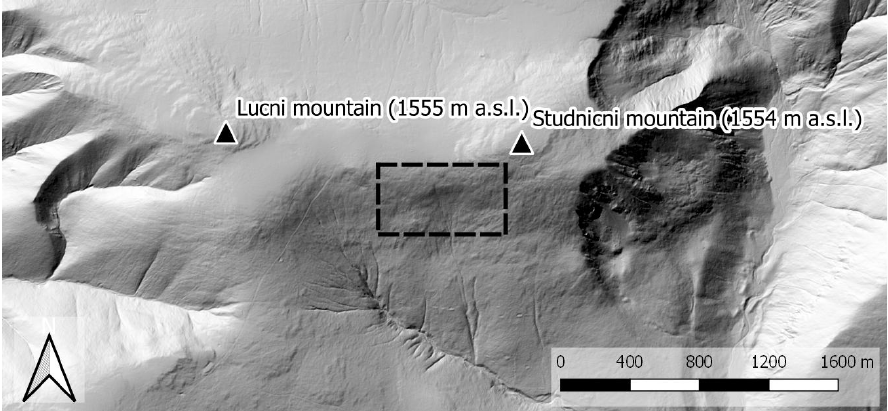
Figure 9. The fifth generation, shaded DTM of the Krkonose (obtained from CUZK). The study area is highlighted by the dashed